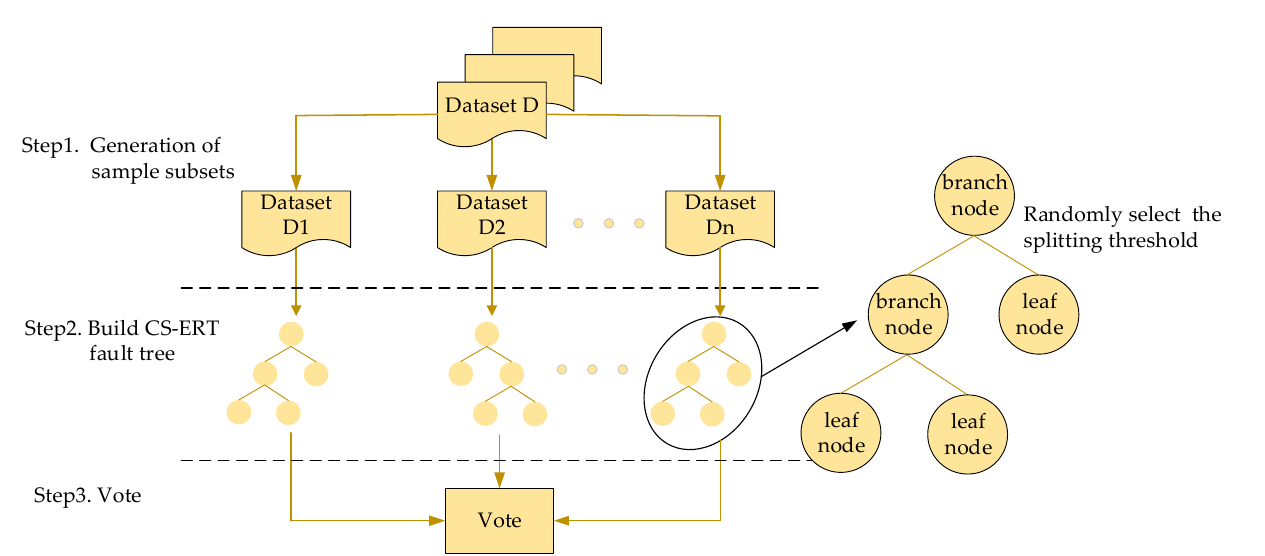
Figure 2. Schematic diagram of the structure of a cost-sensitive extreme random forest.